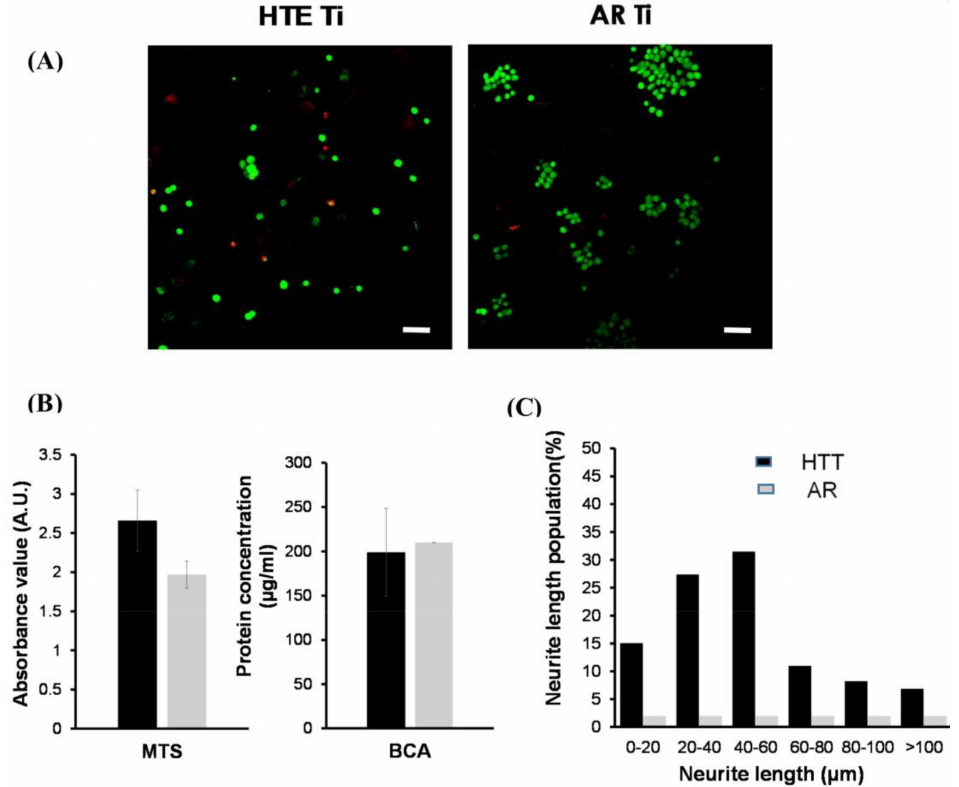
Figure 4. PC12 cell viability and differentiation on HTE and AR Ti surfaces. ( A ) Confocal laser scanning micrographs showing viable (green) and nonviable (red) bacterial cells on the HTE- Ti and AR-Ti surfaces. The majority of PC12 cells still survived on both surfaces after one day of incubation, and the mechanobactericidal surface of HTE-Ti did not have any killing effect towards PC12 cells (scale bar 50 µ m). ( B ) Day 1, PC12 cell attachment and proliferation on HTE-Ti and AR surfaces. MTS (3-(4,5-dimethylthiazol-2-yl)-5-(3-carboxymethoxyphenyl)-2-(4-sulfophenyl)-2 H -tetrazolium) results suggest that the HTE-Ti facilitated cell attachment. No differences were detected in the total protein content (BCA, bicinchoninic acid protein assay) of the two samples tested. ( C ) PC12 cell differentiation on HTE-Ti. PC12 cells present on HTE-Ti surface exhibited enhanced neurite growth for 7 days. The cells grown on the AR surfaces were not able to undergo